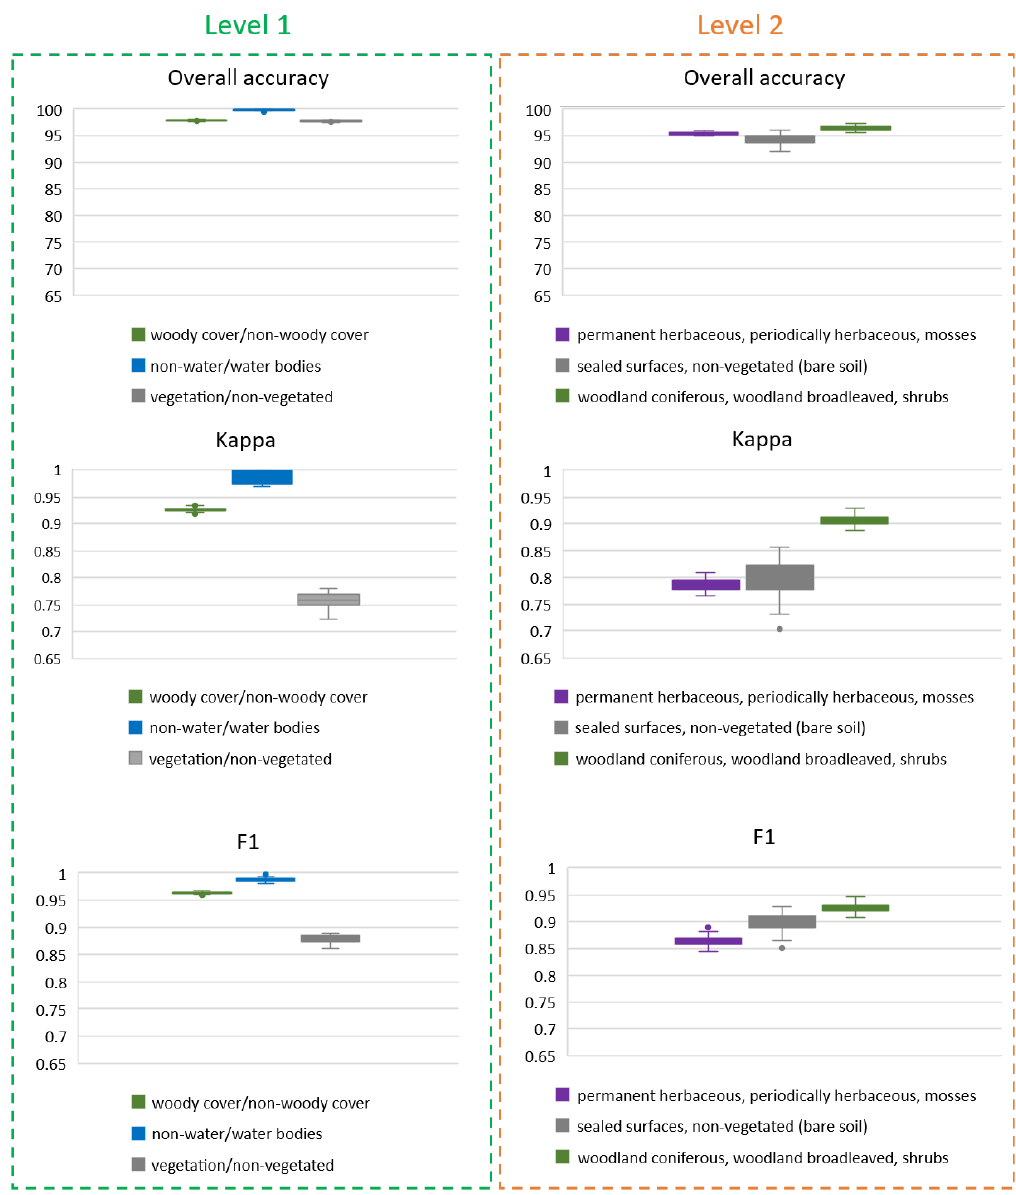
Figure 4 . Variability of overall accuracy (OA), Kappa coefficient and F1 scores for the hierarchical classification at Level 1 and 2 — the results of 100 classification iterations performed on the Sentinel-2 granule no. 34UCC.